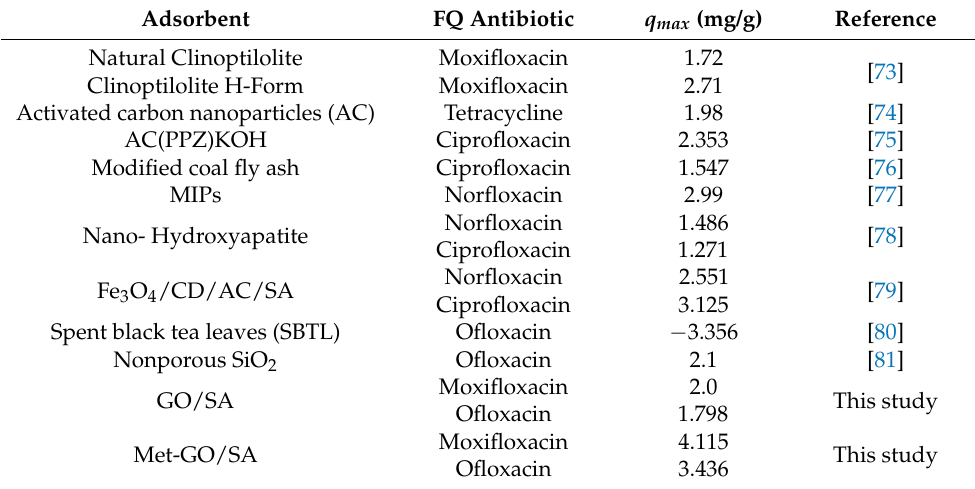
Table 6. Comparison of maximum adsorption capacity ( q max ) of FQ antibiotics reported for different adsorbents.